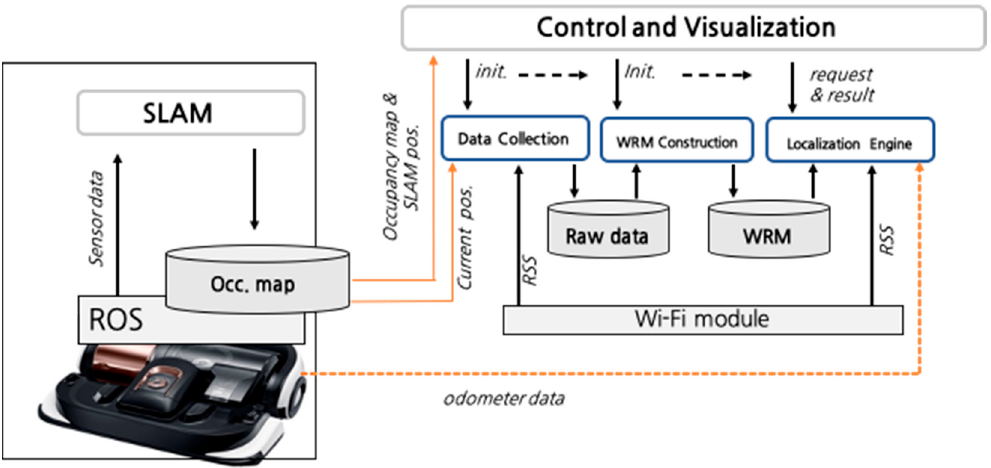
Figure 1. Structure of the robot localization application. SLAM: simultaneous localization and mapping, ROS: robot operating system, WRM: Wi-Fi radio map, and RSS: received signal strength.